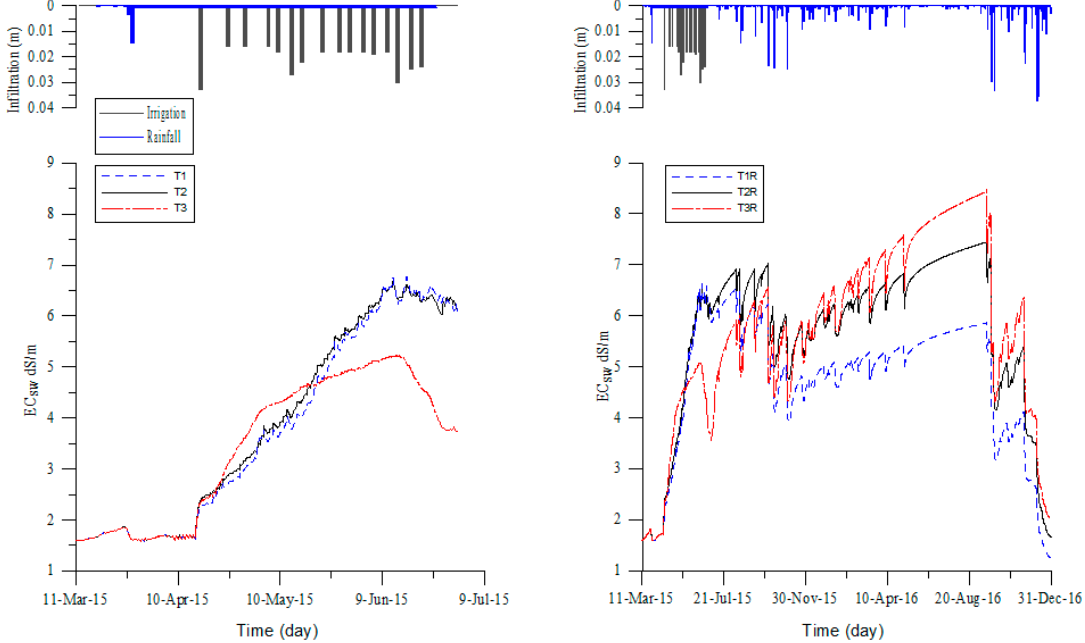
Figure 3. Root zone salinity for different treatments under irrigation and rainfall.